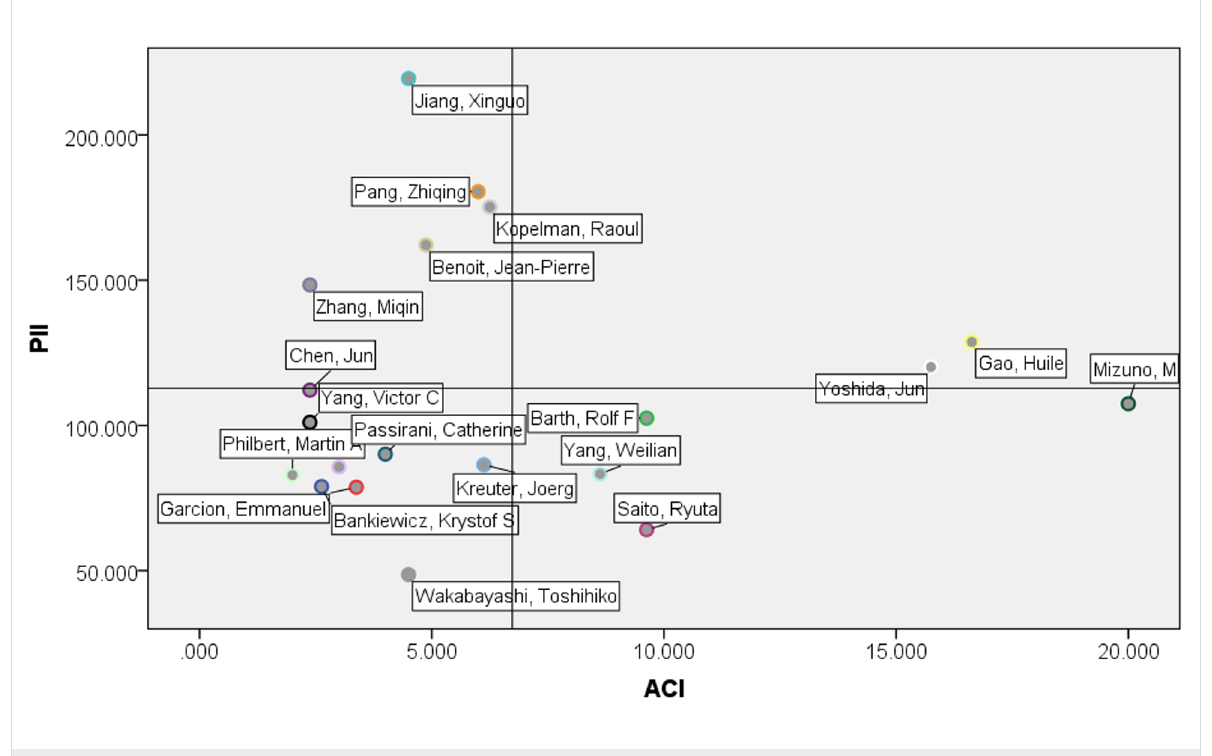
Figure 7: The author activities of top 20 authors in NEDD for brain